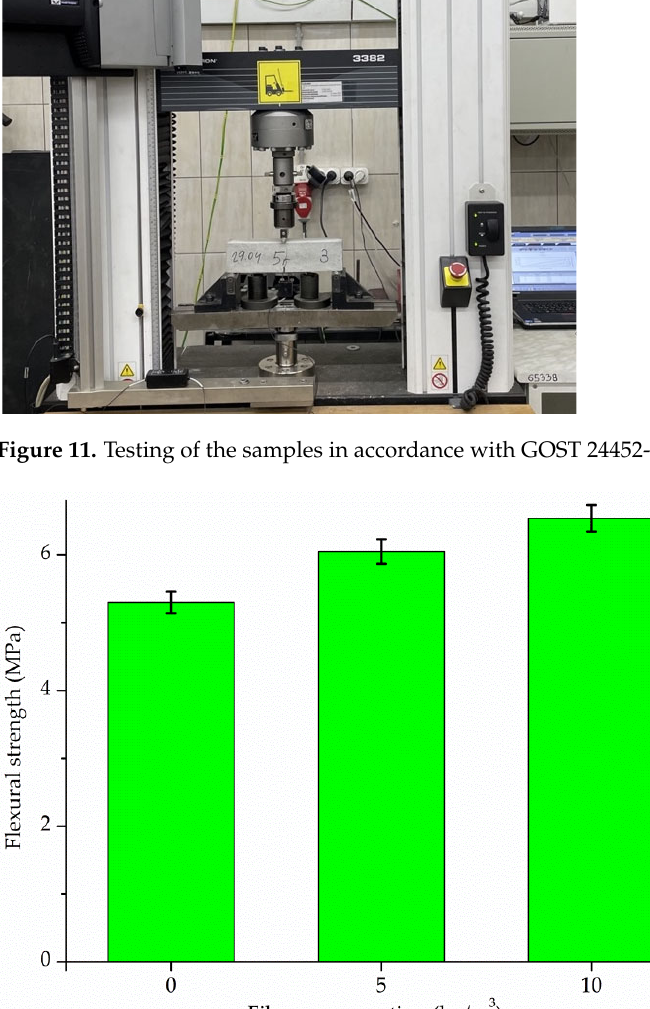
Figure 11. Testing of the samples in accordance with GOST 24452 ‐ 80.